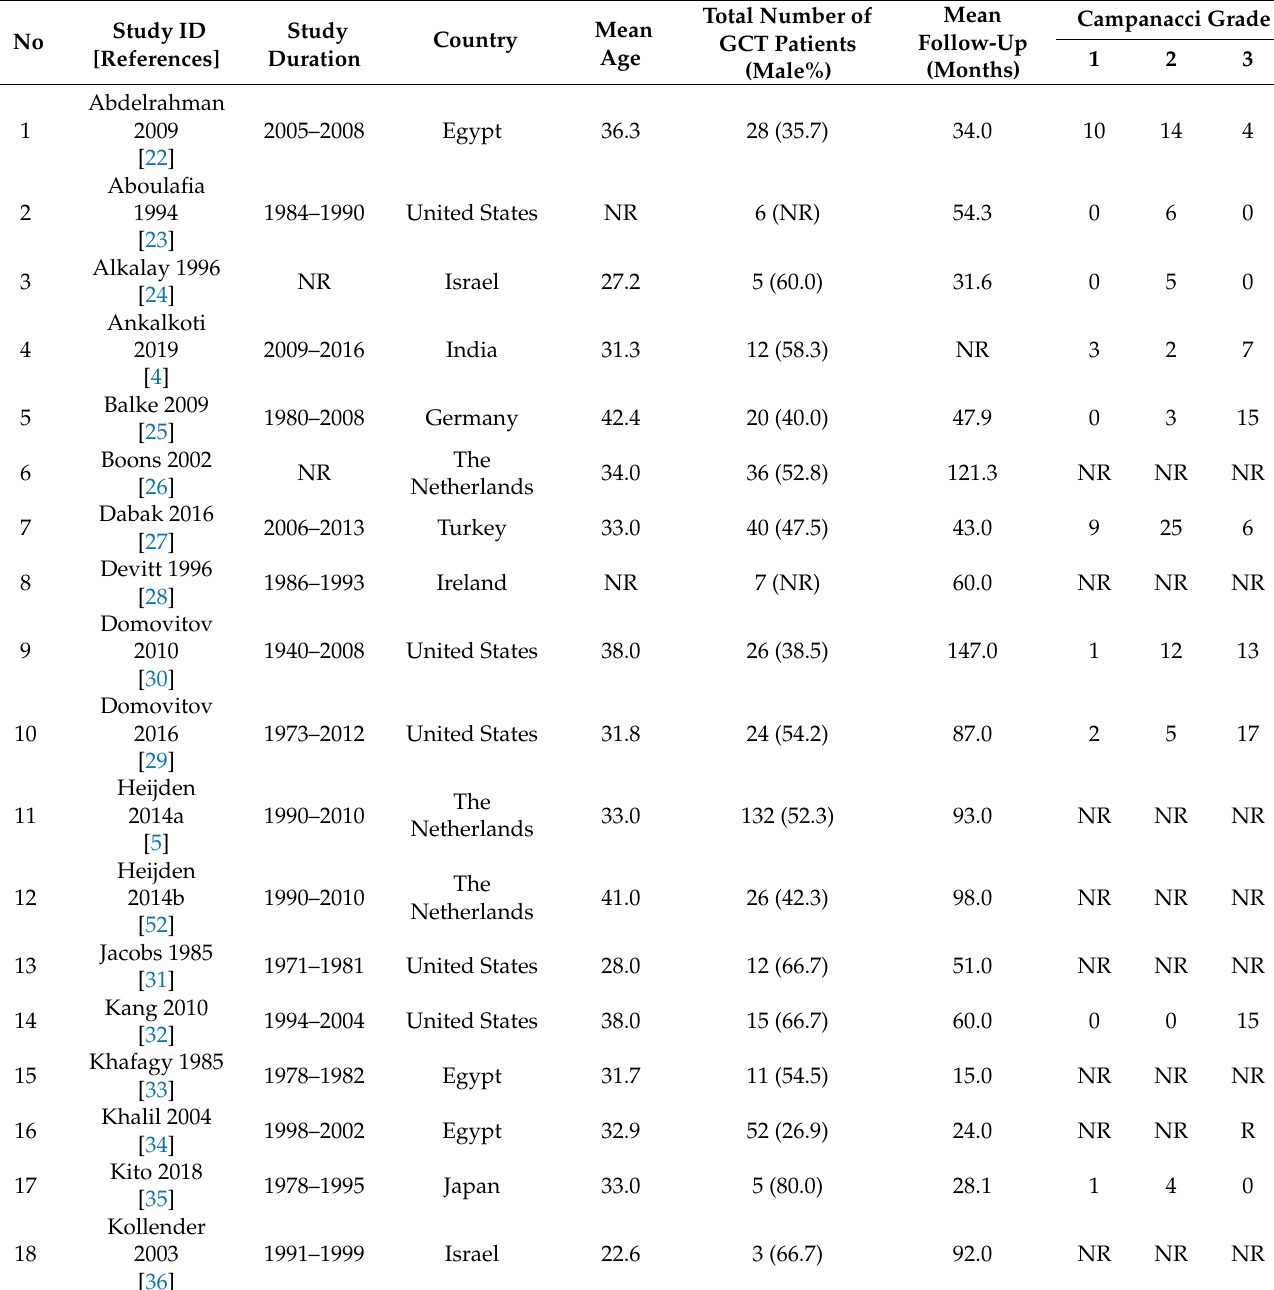
Table 1. Major characteristics of the included